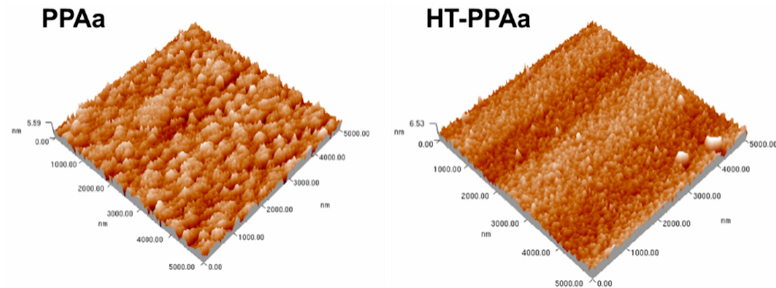
Figure 2. Atomic Force Microscopy (AFM) results of the PPAa and HT-PPAa film surface topography.